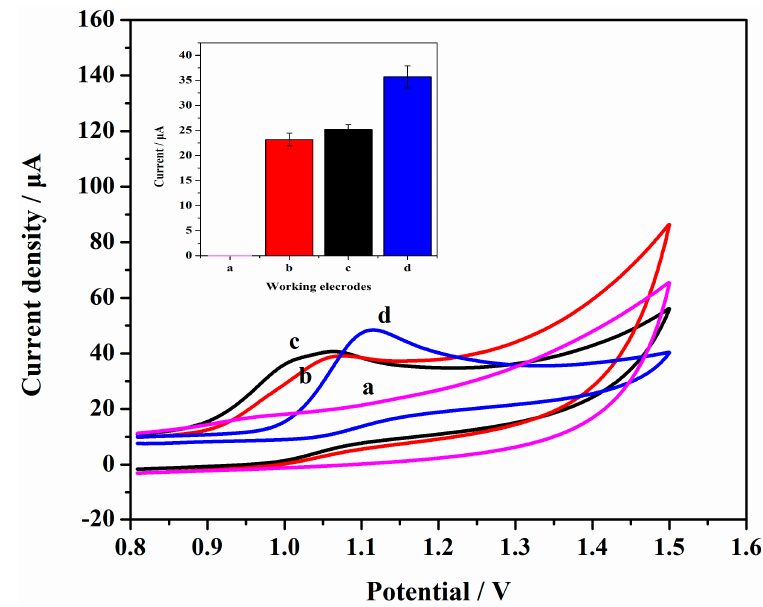
Figure 5. Cyclic voltammetry (CV) curves of (a) bare GCE without Sulfanilamide (SAM); (b) bare GCE; (c) Gr/GCE; and (d) AuNPs/Gr/GCE in 1.0 × 10 − 3 mol·L − 1 SAM (pH = 2.0) .The inset is the quantification of peaks appearing on the voltammogram. The potential sweep rate was 100 mV·s − 1 .